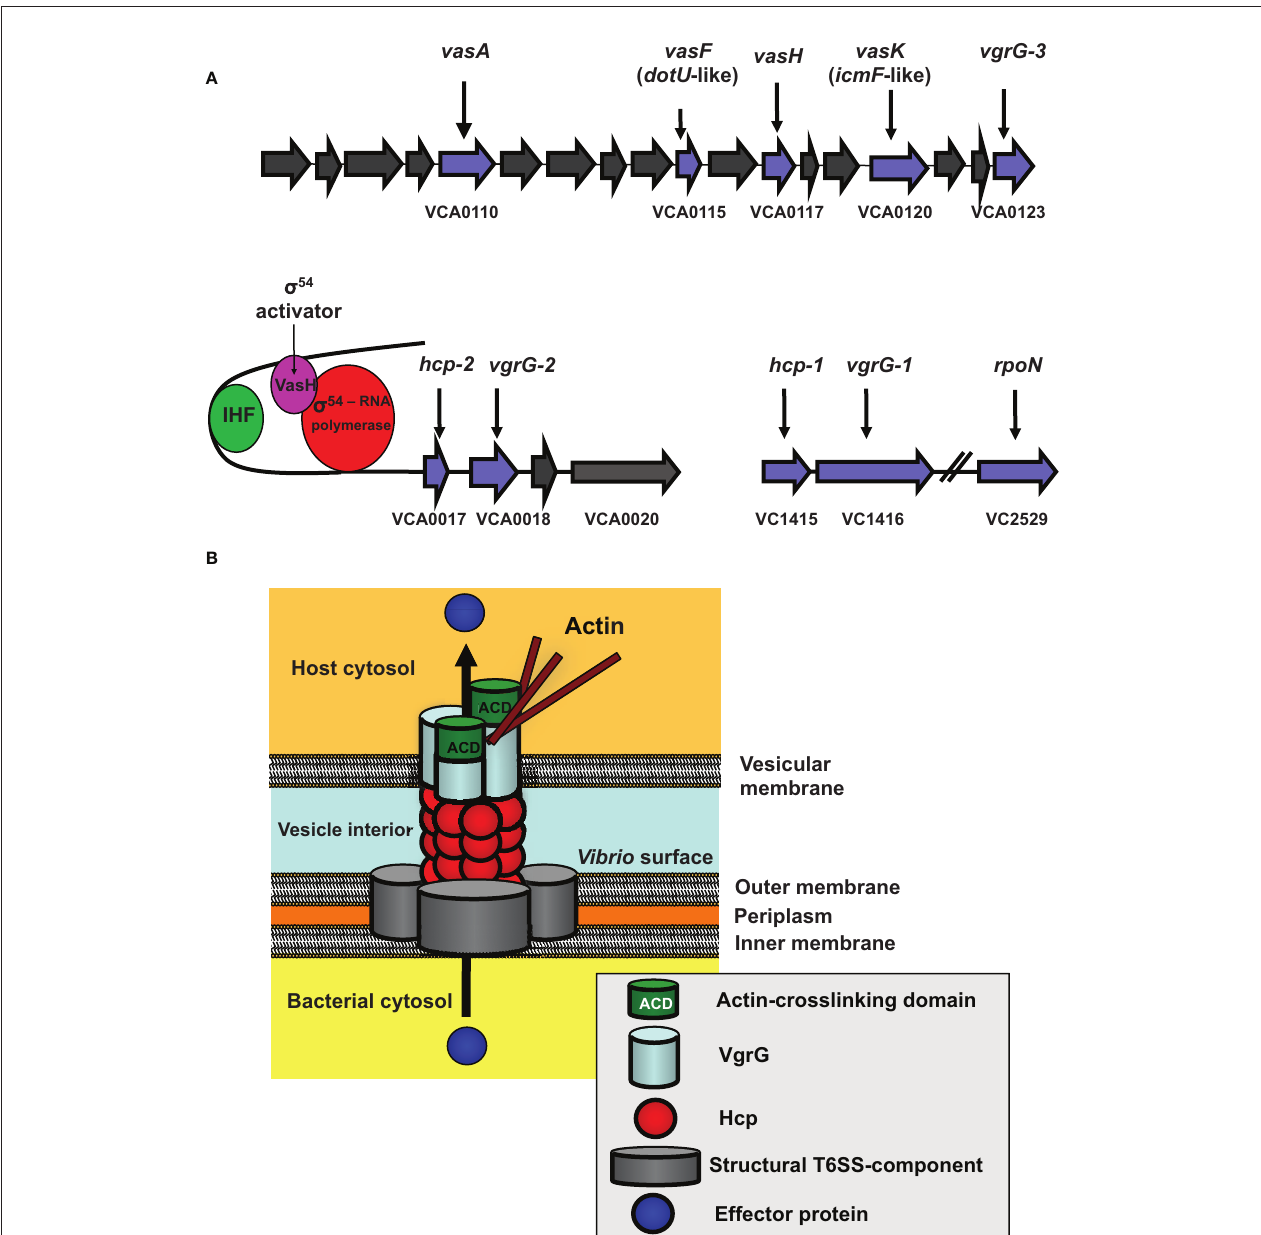
FIgure 1 | The V. cholerae Type VI Secretion System (T6SS) . (A) The T6SS gene clusters. The three gene clusters contain genes of predicted (blue) and unknown (gray) functions. VCA0117 encodes the gene designated vasH . Also shown is the VasH-dependent regulation of the T6SS genes. (IHF, integration